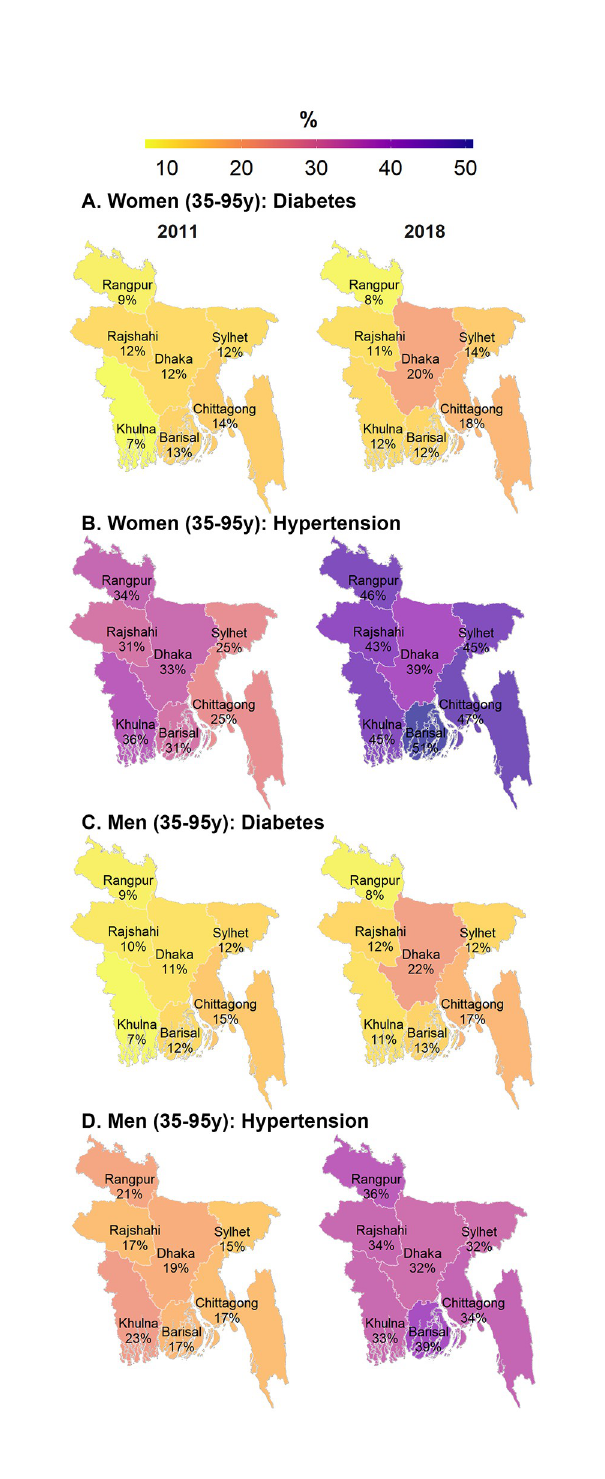
Fig 4. Prevalence of noncommunicable diseases among women and men by division and survey round, Bangladesh 2004–2018. (A) Women (35-95y): Diabetes. (B) Women (35-95y): Hypertension. (C) Men (35-95y): Diabetes. (D) Men (35-95y): Hypertension. Note: This map is created from the shapefile (an empty map) that is publicly available from http://gadm.org.